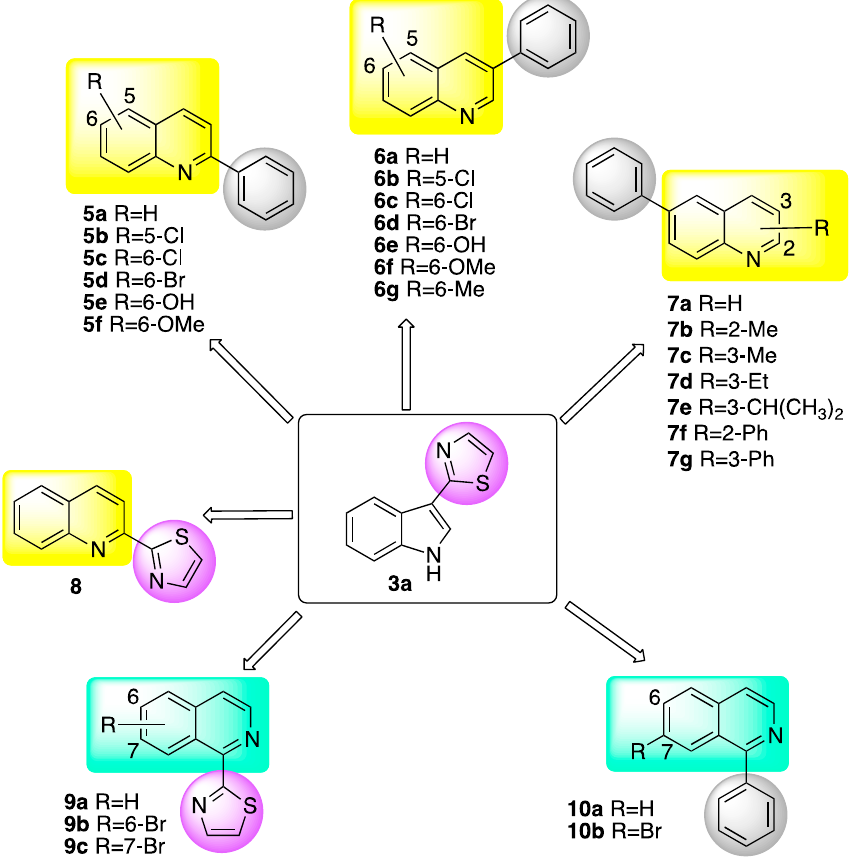
Figure 1. Quinolines 5a – 8 and isoquinolines 9a – 10b evaluated for inhibition of BOLm.